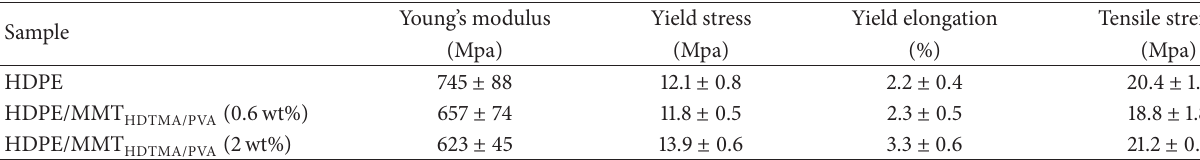
Table 2: Mechanical properties of the materials.